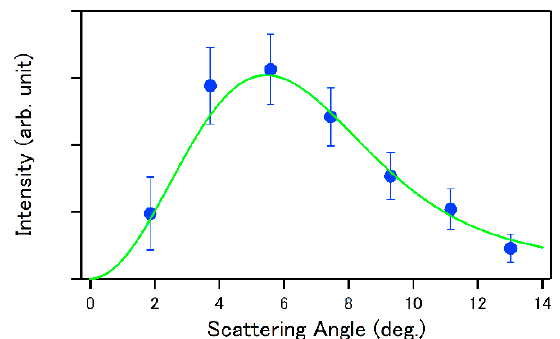
Figure 5. The angular distributions of LAES for the n = +1 transitions with the vertically polarized laser field [9]. The blue filled circles are the observed LAES signals of n = +1 and the green solid line is obtained by the numerical calculation by KWA. Estimated statistical error bars were derived from square roots of the signal counts. The experimental conditions are the same as those in Figure 2.